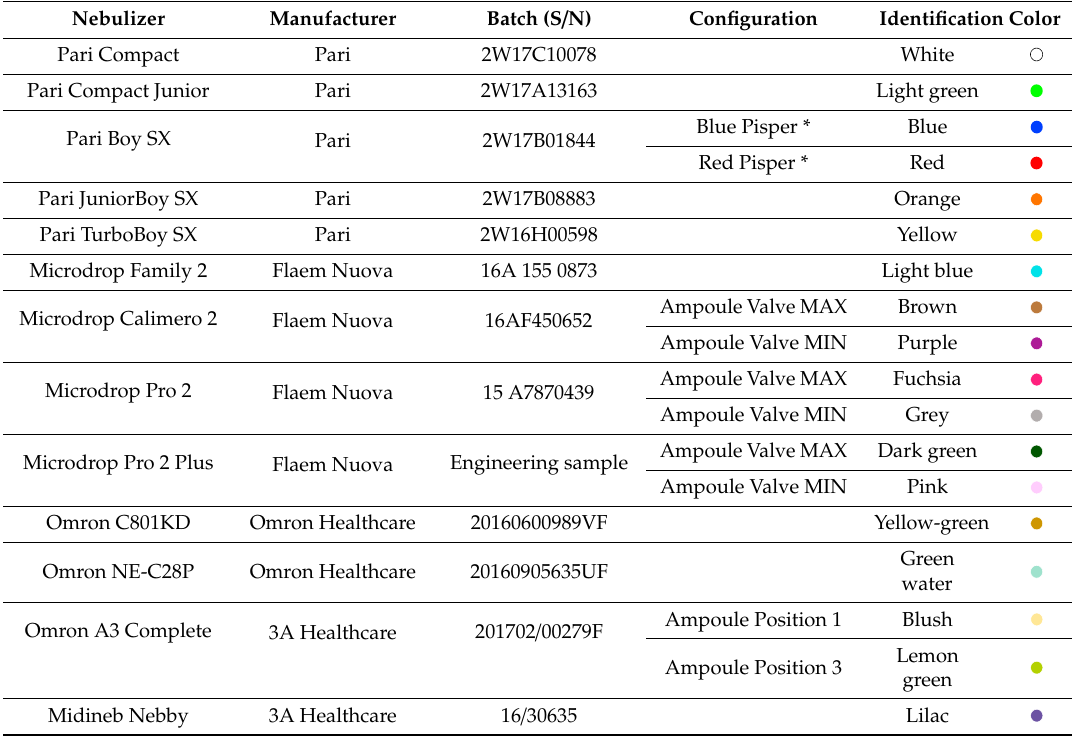
Table 1. List of the pneumatic nebulizers used in this study.